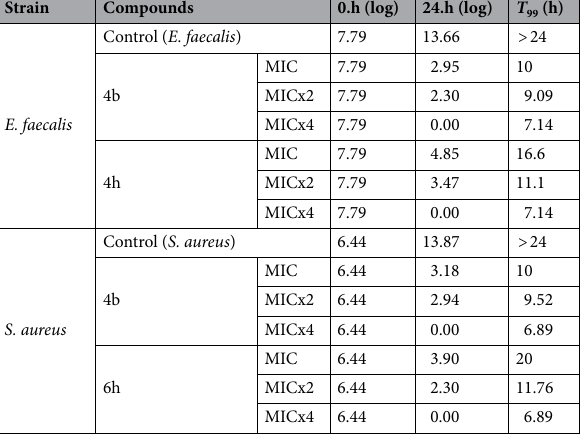
Table 5. t 99 values of the strains in the MIC, MICx2 and MICx4